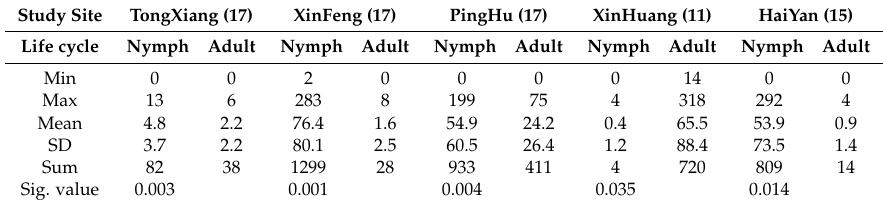
Table 1. Statistical description of nymph and adult densities of Laodelphax striatellus *. Study Site